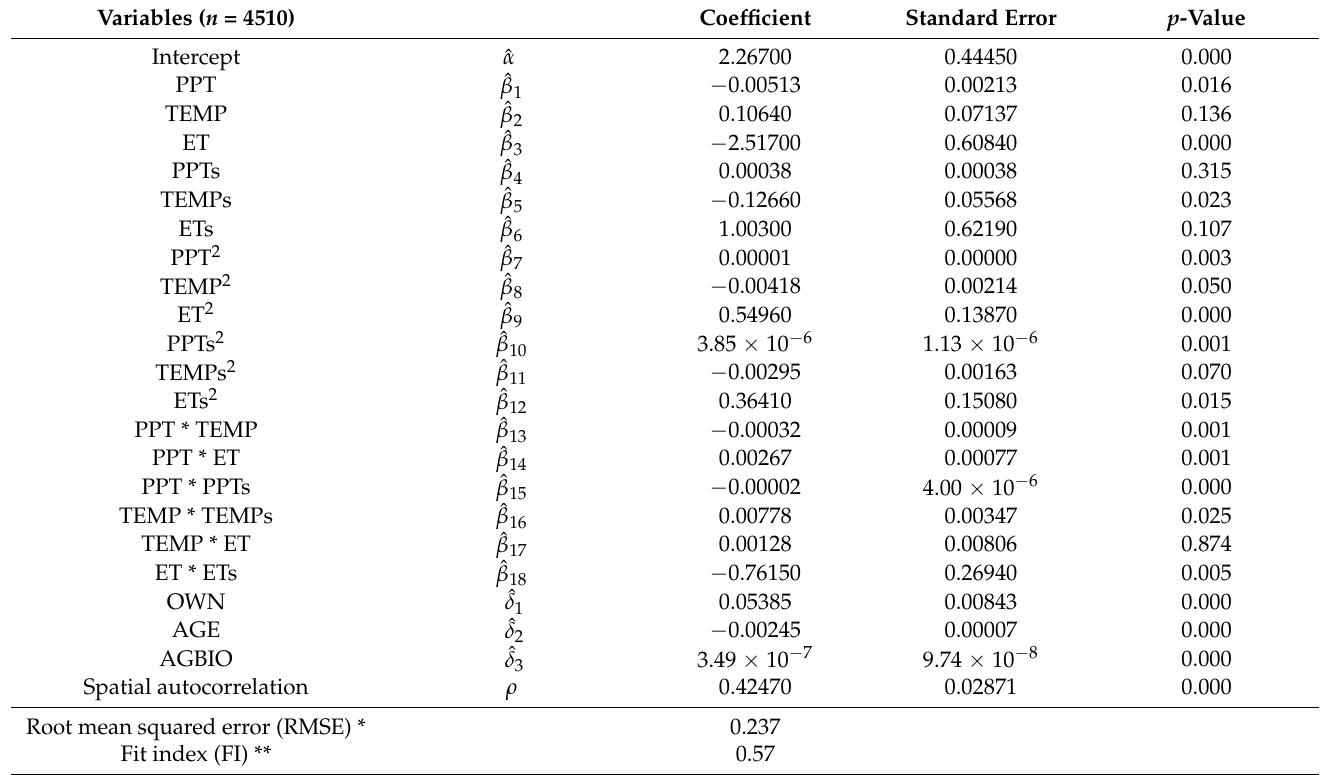
Table 4. TreeBio-Loss model to estimate biomass loss due to tree mortality in the forested FIA plots of the continental United